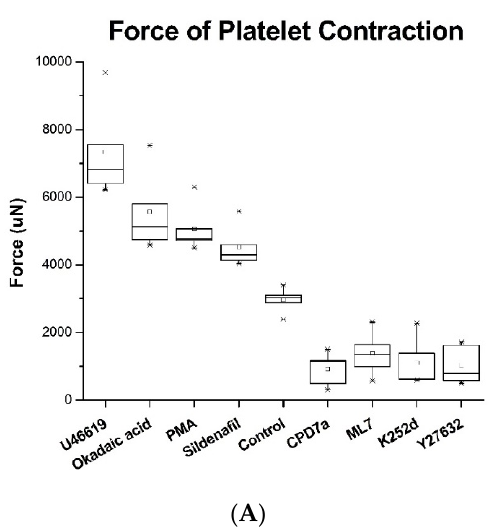
Figure 3. Force of platelet contraction ( A ) and degree of MLC phosphorylation ( B ) varied due to the addition of various stimulating or inhibiting compounds (n = 5, error bars = interquartile range). The control group was stimulated with only calcium. Stimulators like U46619, okadaic acid, PMA, and sildenafil demonstrate an increase in platelet contraction force and MLC phosphorylation. Inhibitors like CPD7a, ML7, K252d, and Y27632 cause a decrease in platelet contraction force and MLC phosphorylation. × represents outliers in the data set.